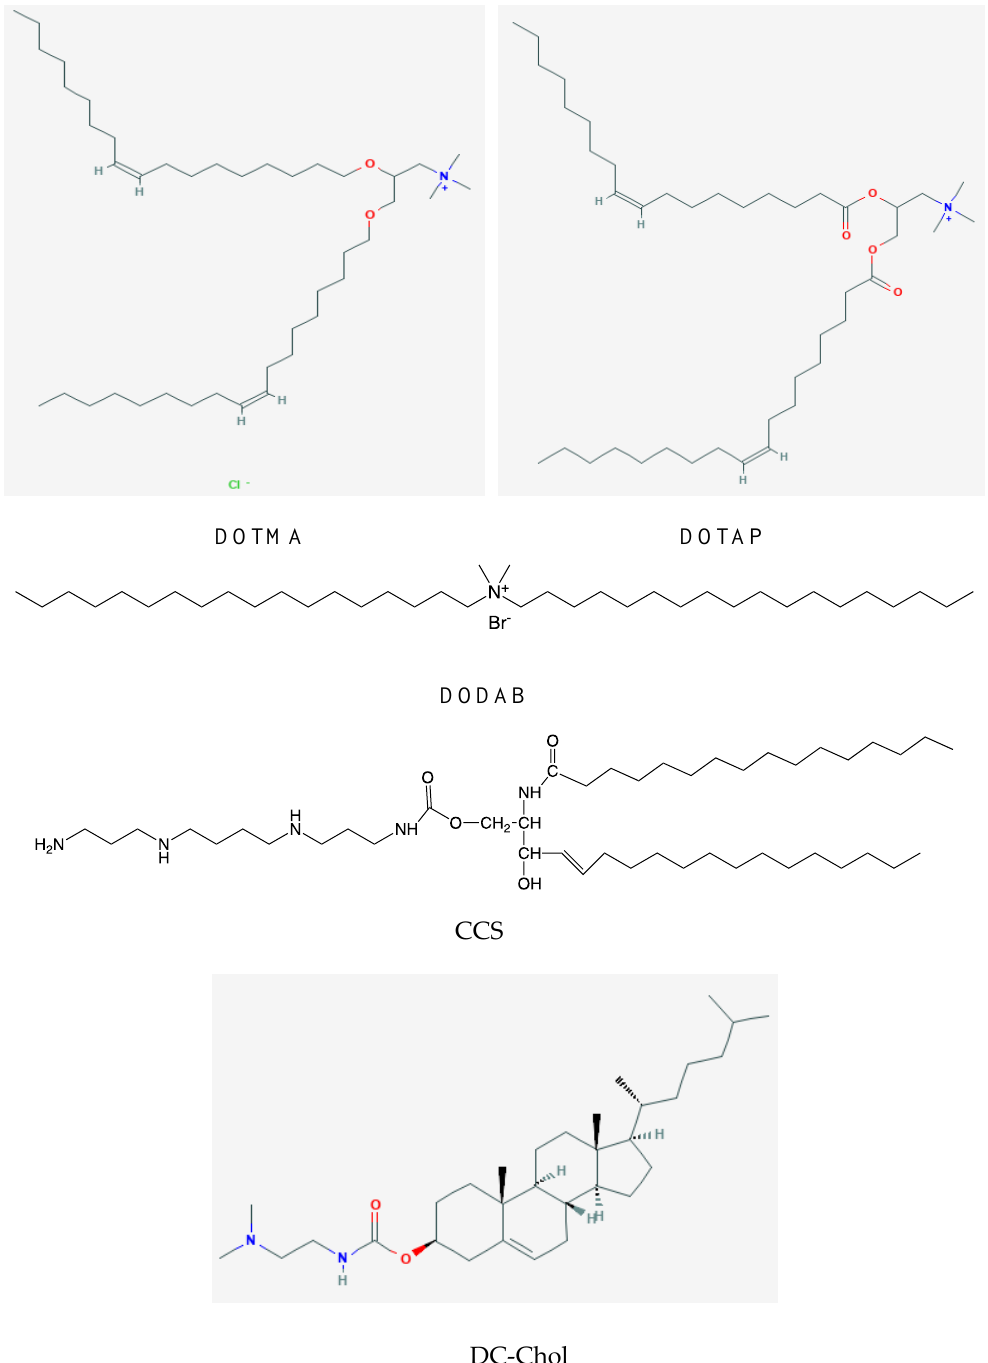
Figure 1. Chemical structure of cationic lipids or surfactants used to formulate vaccines. They bear the cationic charges of primary or secondary amino groups or quaternary ammonium nitrogens in their structures which combine with oppositely charged antigens. CCS is N-palmitoyl d-erythro-sphingosyl-1-0-carbamoyl-spermine triacetate salt. The CCS chemical structure was reprinted from [50] with permission from Elsevier, Copyright 2006.